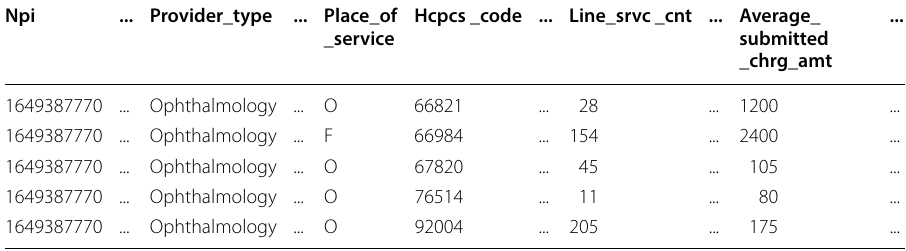
Table 1 Sample of the Part B